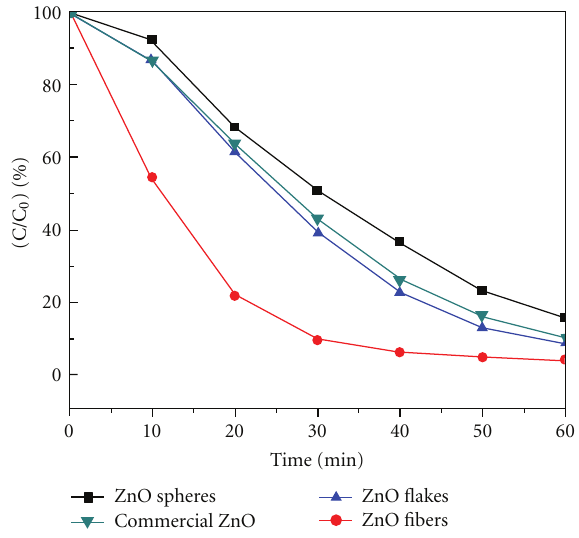
Figure 8: Comparison of photocatalytic e ff ects of various ZnO